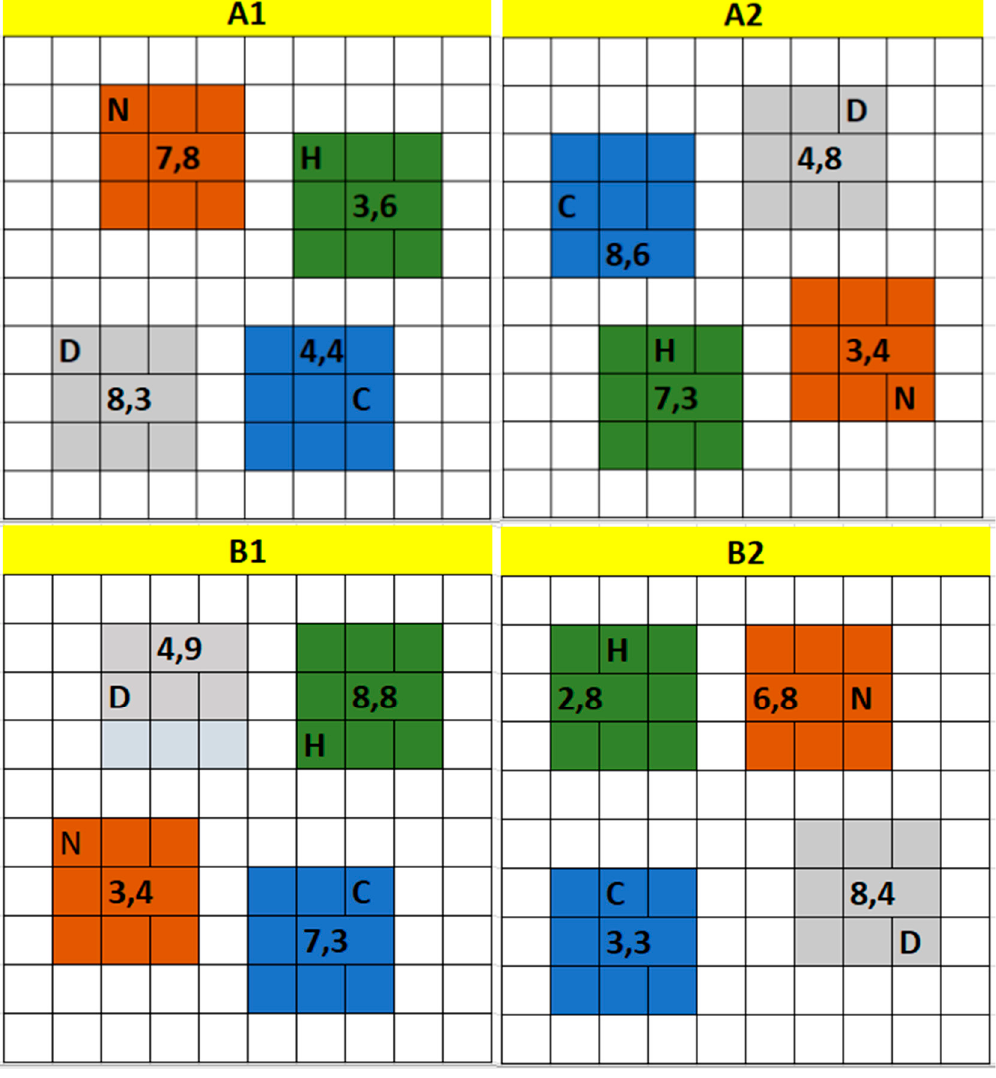
Figure 1. Layout of the blocks showing randomized locations of subplots. “C” = control treatment, “D” = digestate treatment, “N” = urea treatment, “H” = hydrochar treatment. Blocks A1 and A2 are located in site A while blocks B1 and B2 are located in site B. Numbers separated by commas indicate coordinates (m) of soil collar measured from the southeast corner of the plot.